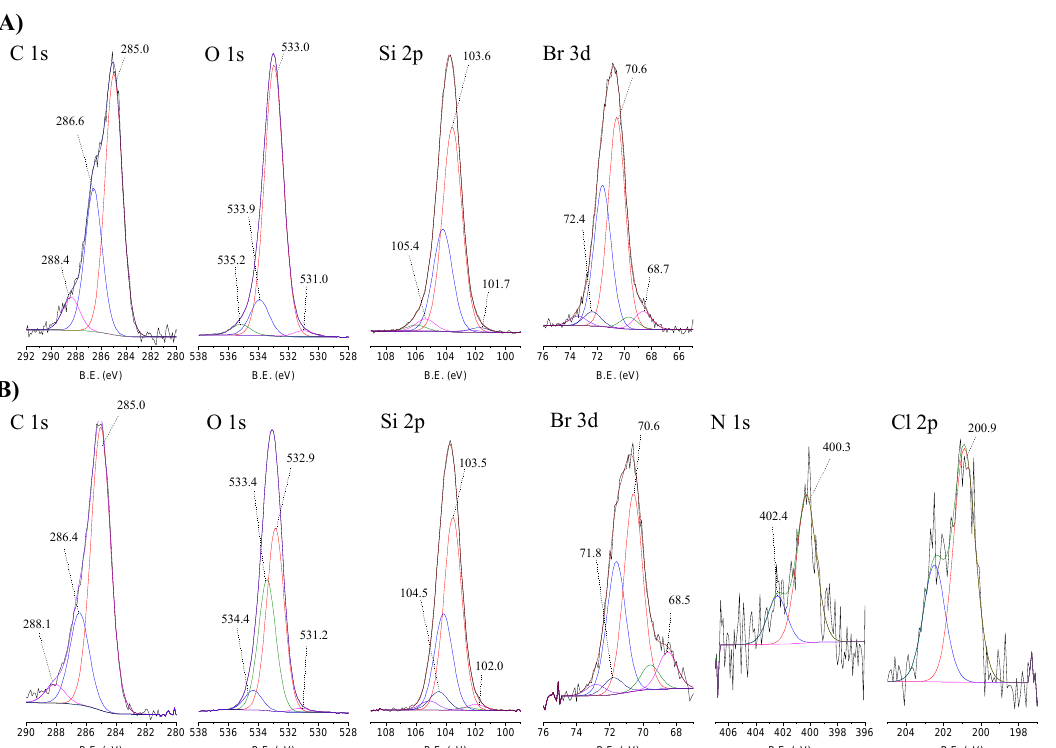
Figure 5. High-resolution XPS spectra in the C 1s, O 1s, Si 2p, Br 3d, N 1s and Cl 2p regions with the corresponding fits for ( A ) Si and ( B ) CAT-4-Si .